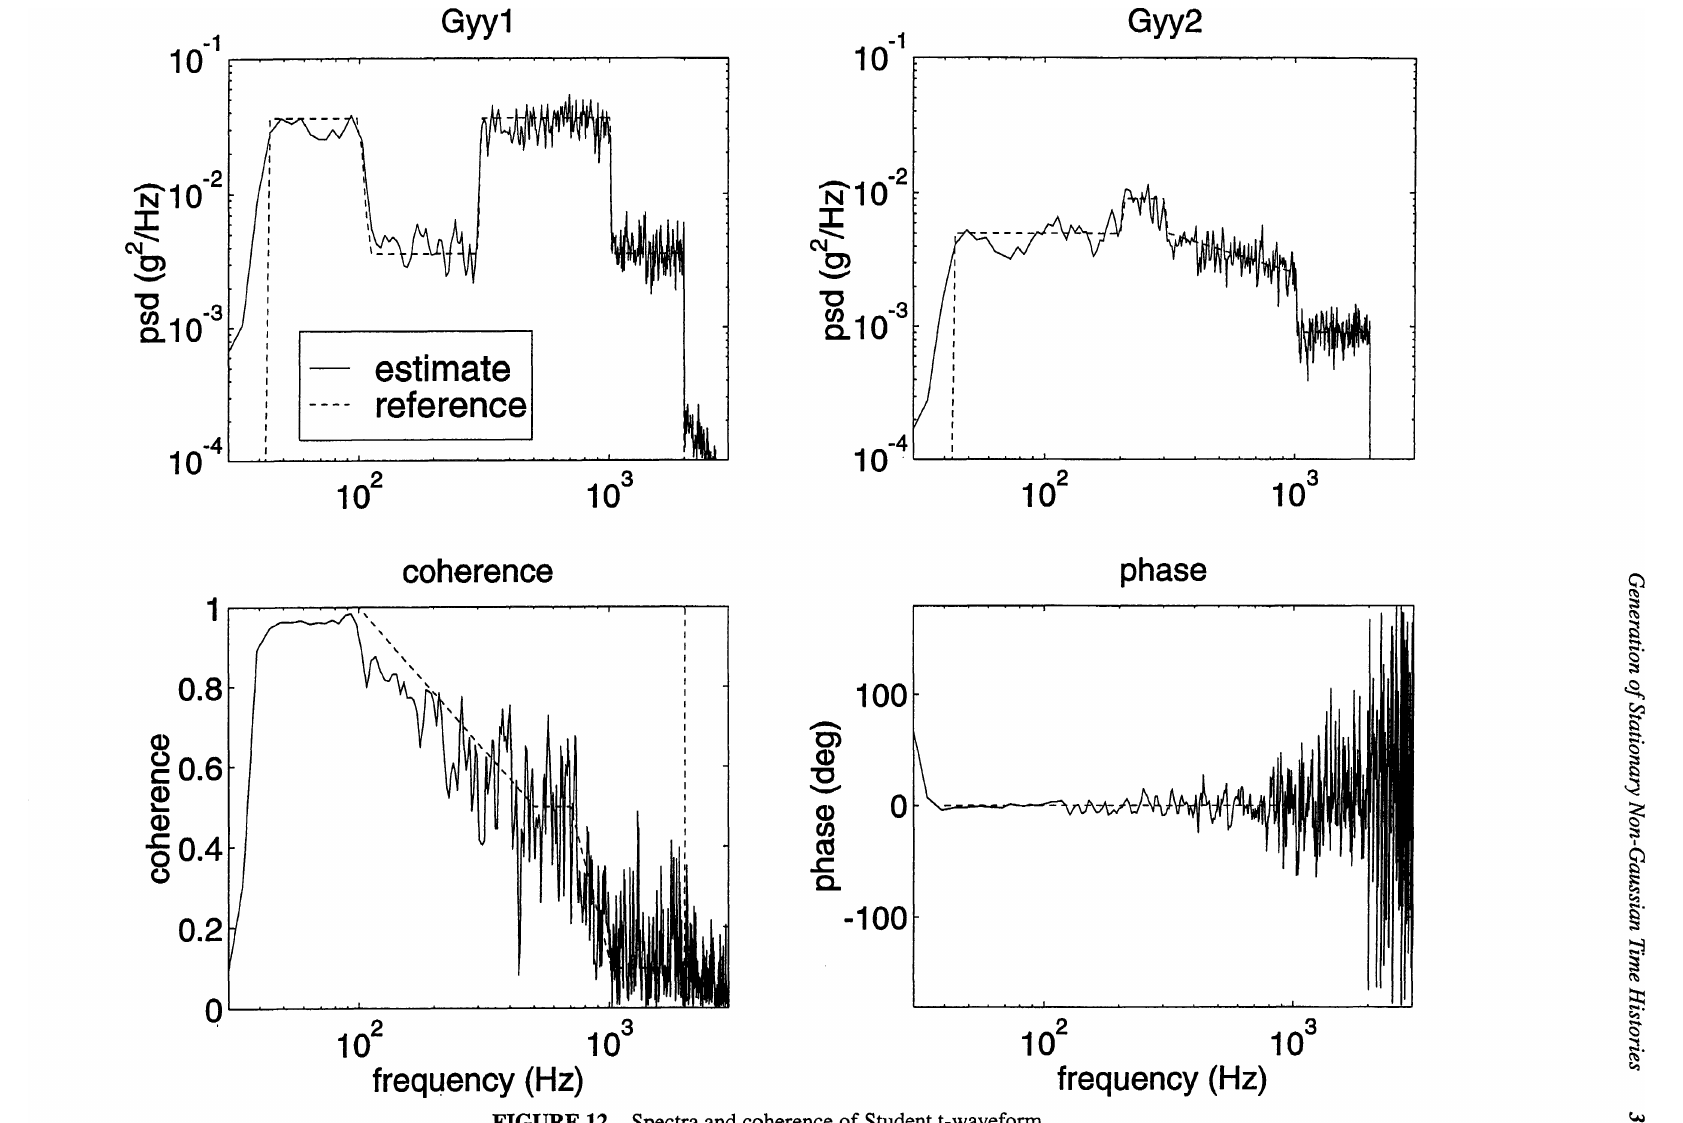
FIGURE 12 Spectra and coherence of Student